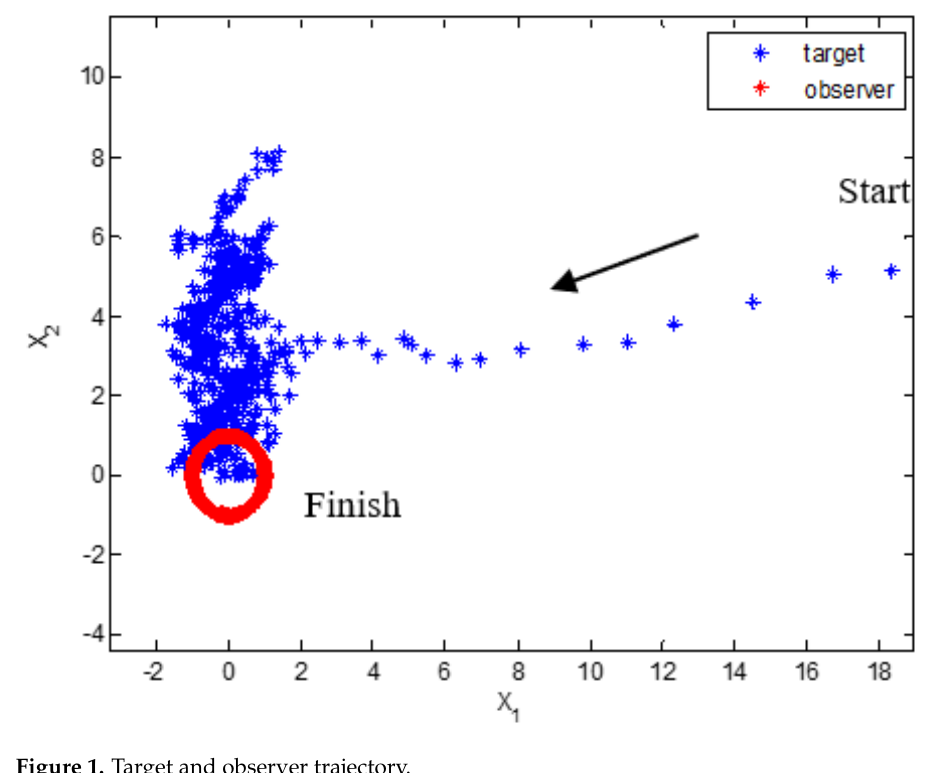
Figure 1. Target and observer trajectory.